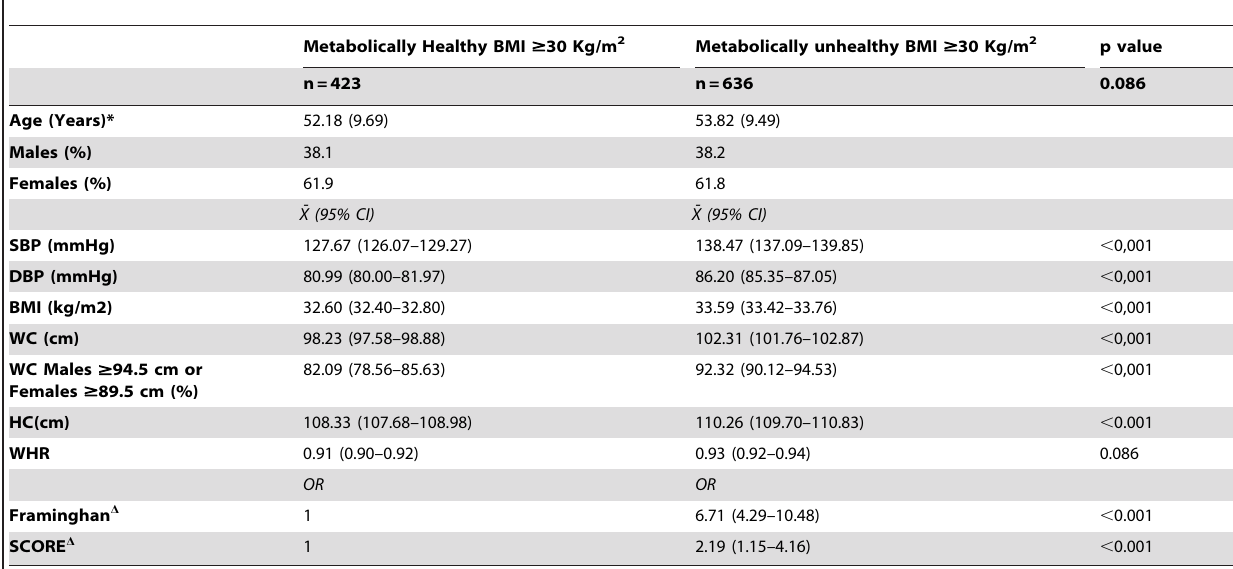
Table 4. Basic characteristics and anthropometric parameters in individuals with BMI $ 30 Kg/m 2 by Consensus Societies criteria, means adjustment by age and